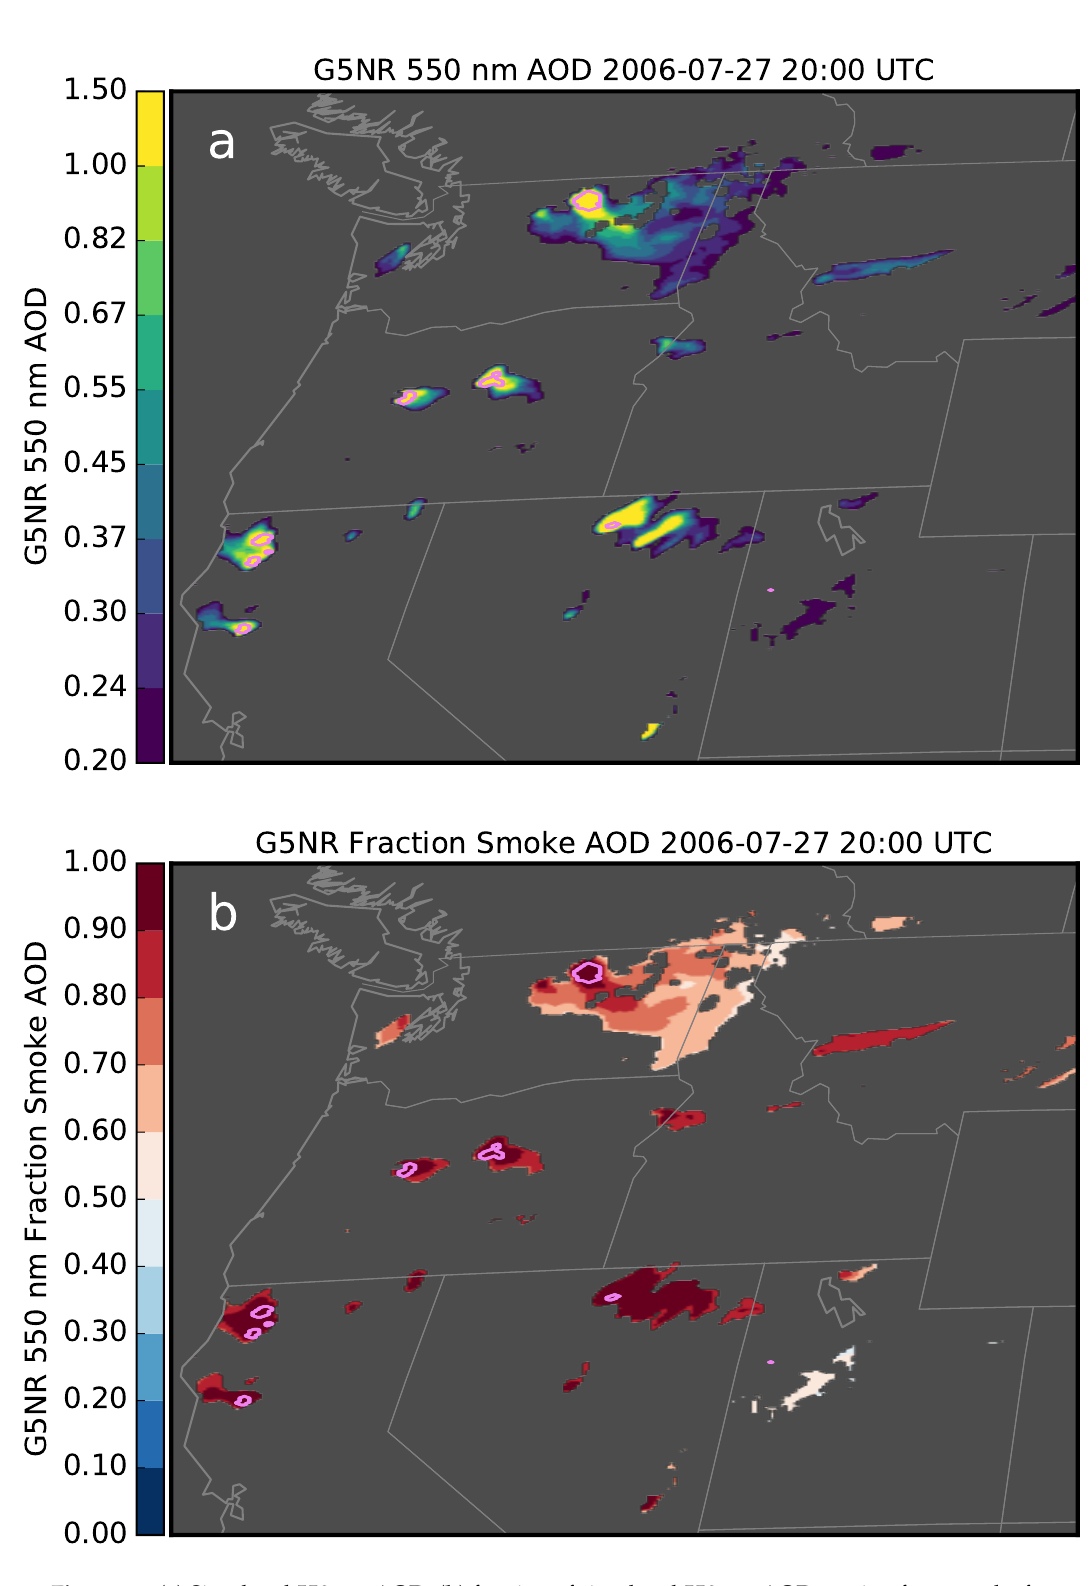
Figure 12. ( a ) Simulated 550 nm AOD, ( b ) fraction of simulated 550 nm AOD coming from smoke for 27 July 2006 at 21 UTC in the G5NR simulation. The purple contours represent the areas that were detected as smoke by the VIIRS aerosol detection